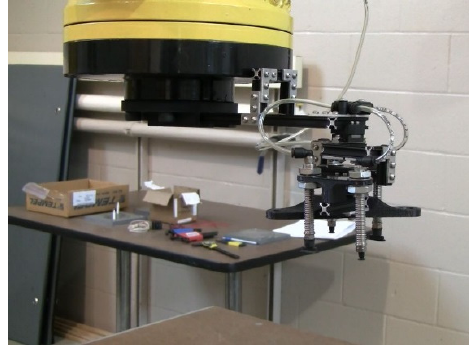
Figure 1. The end-effector attached to the robot wrist-assembly.